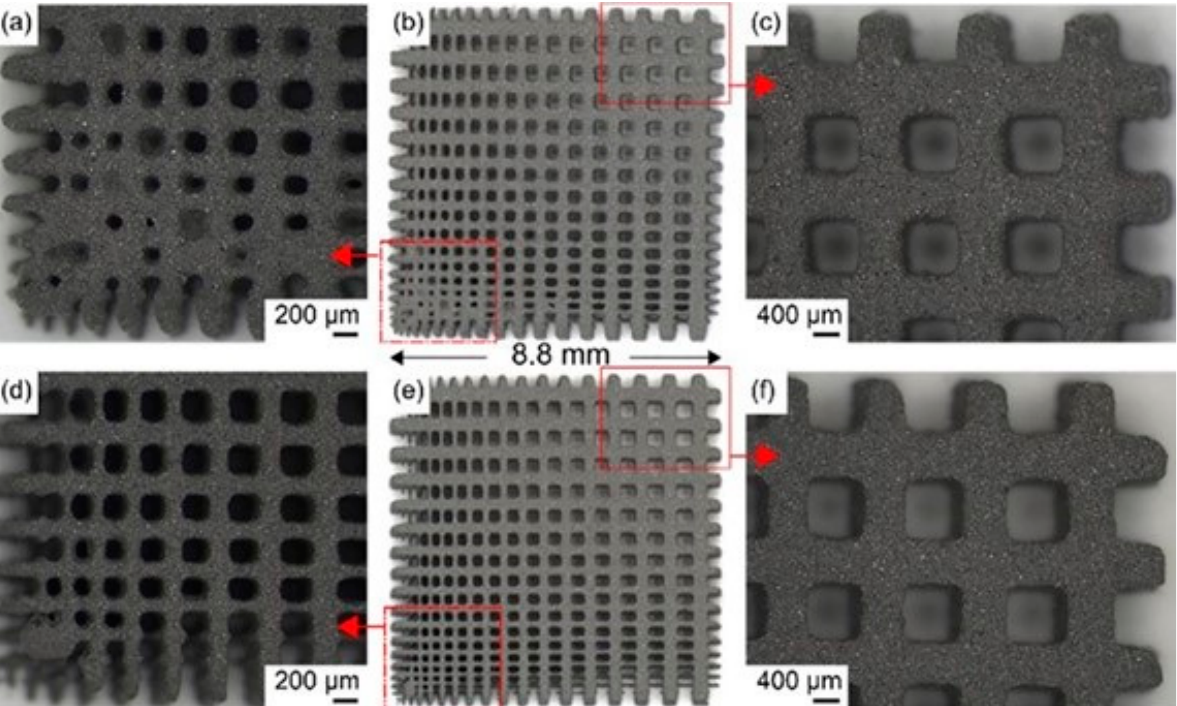
Figure 1. Adhesive powder for molded parts printed using binder jetting. Reprinted with permission from Ref. [62]. Copyright 2015, copyright Jurisch M, Studnitzky T, Andersen O. Comparison